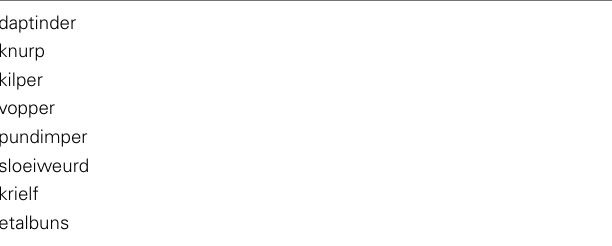
TableA2 | Nonsense words used in Experiment